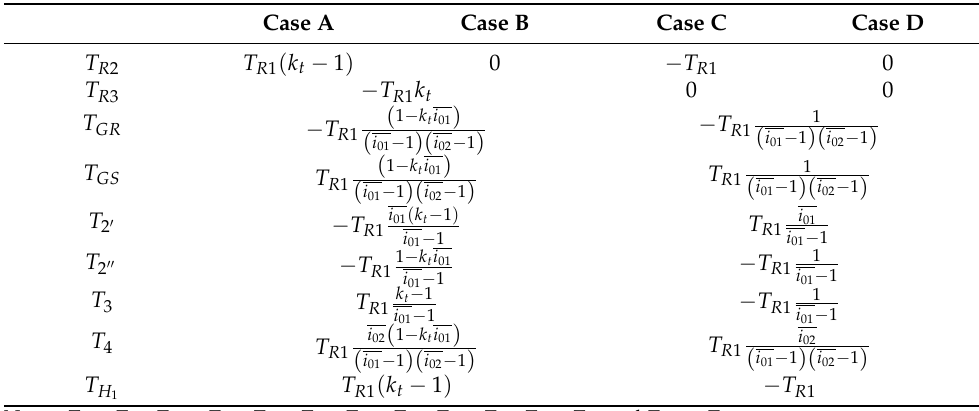
Table 2. Expressions of WSCG torques related to the four cases (Figures 1 and